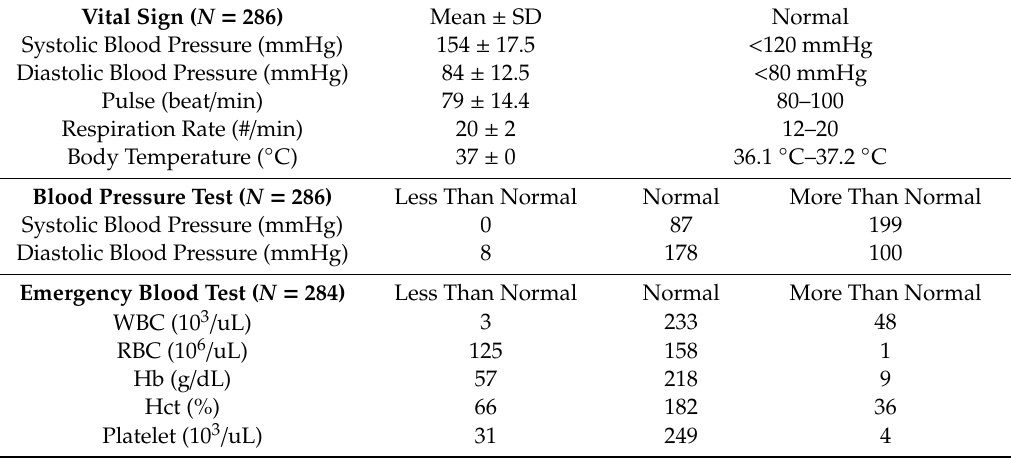
Table 3. Characteristics of the emergency room for stroke